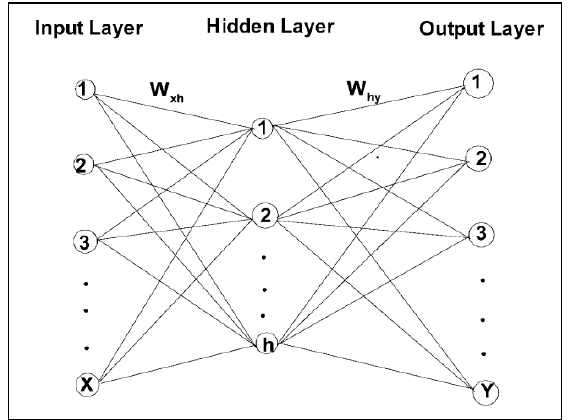
Figure 2 Building of an official Neural Network (T.L. Lee,